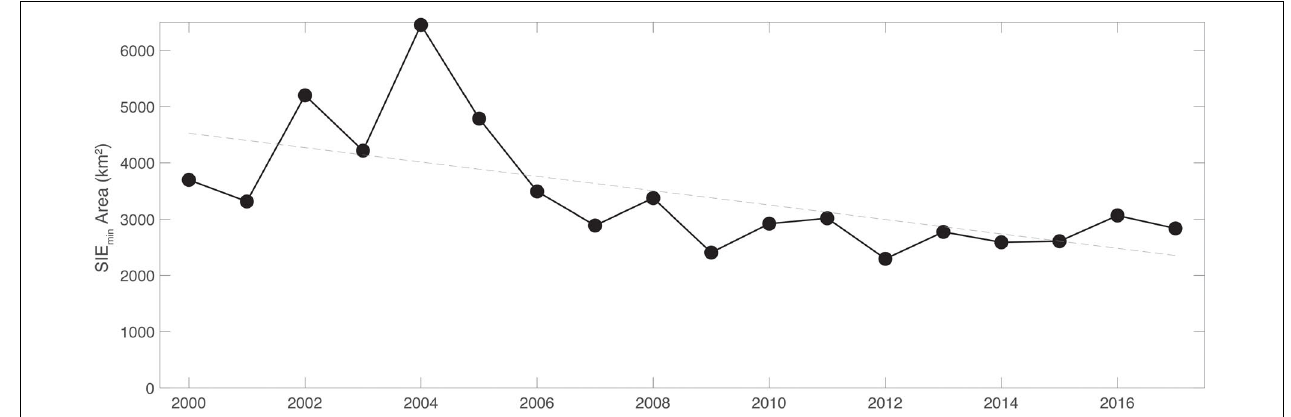
FIGURE 5 | The trend in annual minimum snow and ice area extent (SIE min ) in the Chamkhar Chhu basin shows a statistically significant decline in minimum snow and ice coverage from 2000 to 2017 as calculated using fractional SIE min